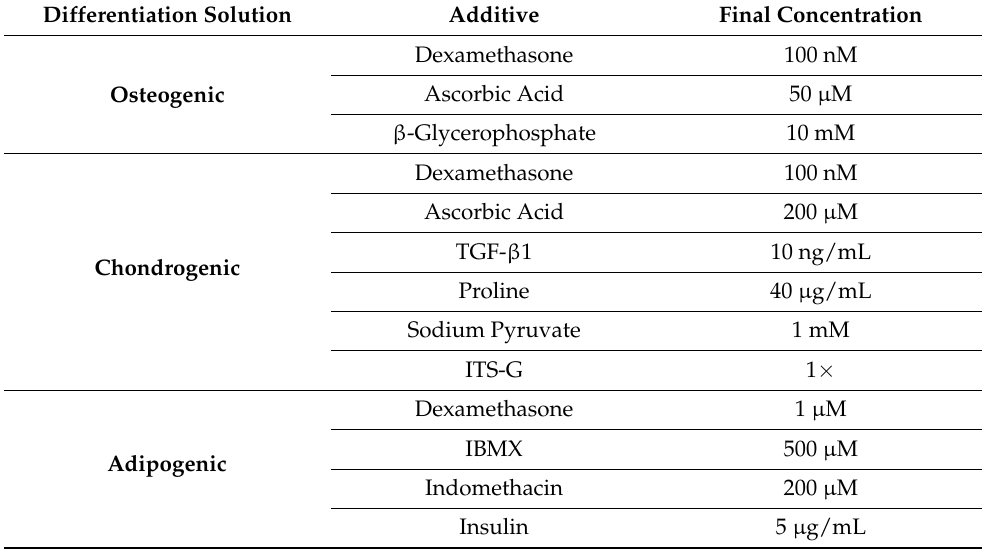
Table 2. List of differentiation media additives including additive name and respective final concentration. Differentiation